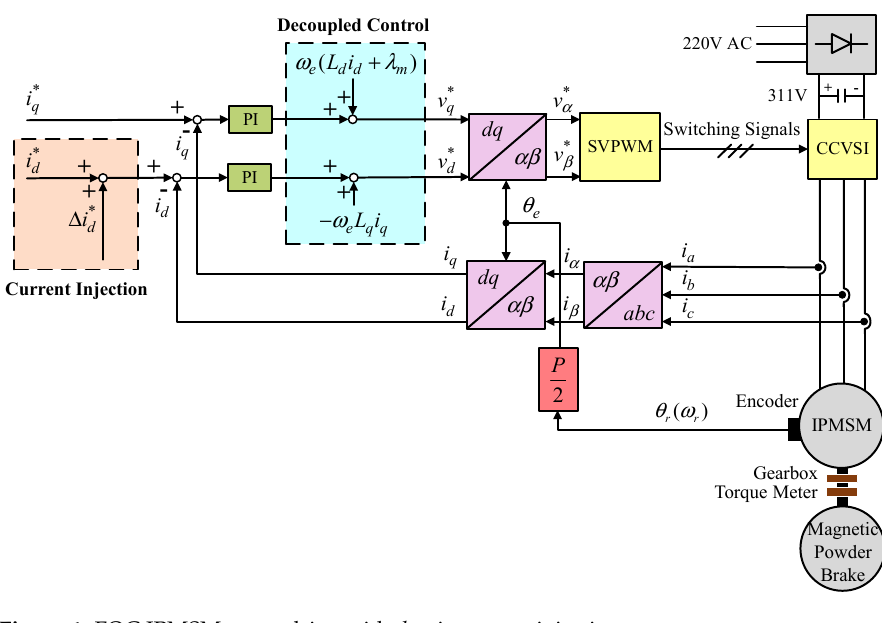
the very short duration of current injection. After measuring, the estimation of the CCVSI distorted voltage term and IPMSM parameters is performed.